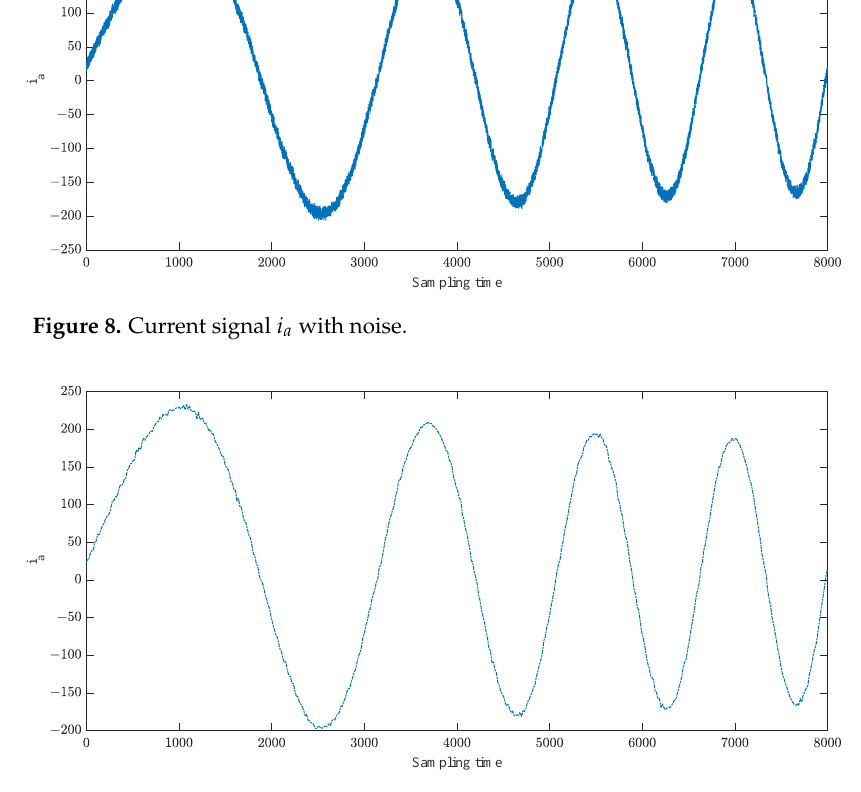
Figure 9. Current signal i a with noise